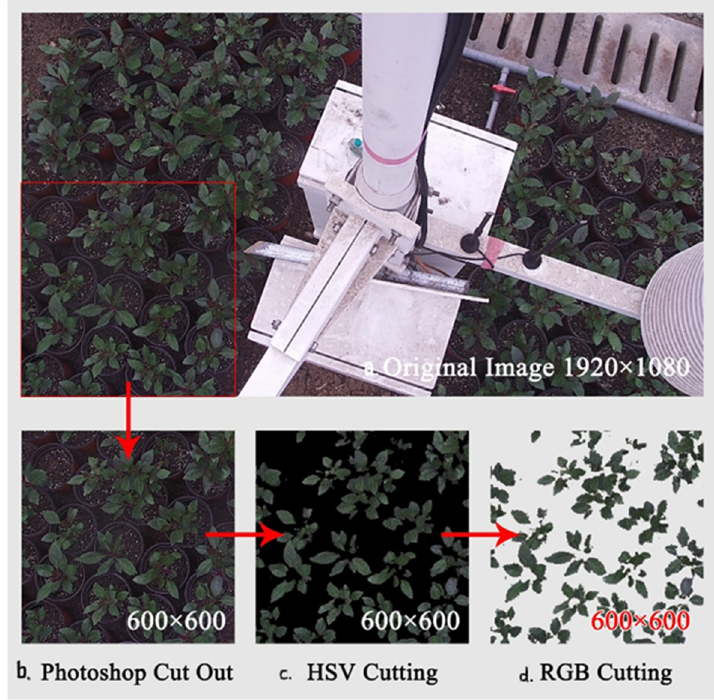
Figure 2. Flow map of Cutting and Denoising of the Image.